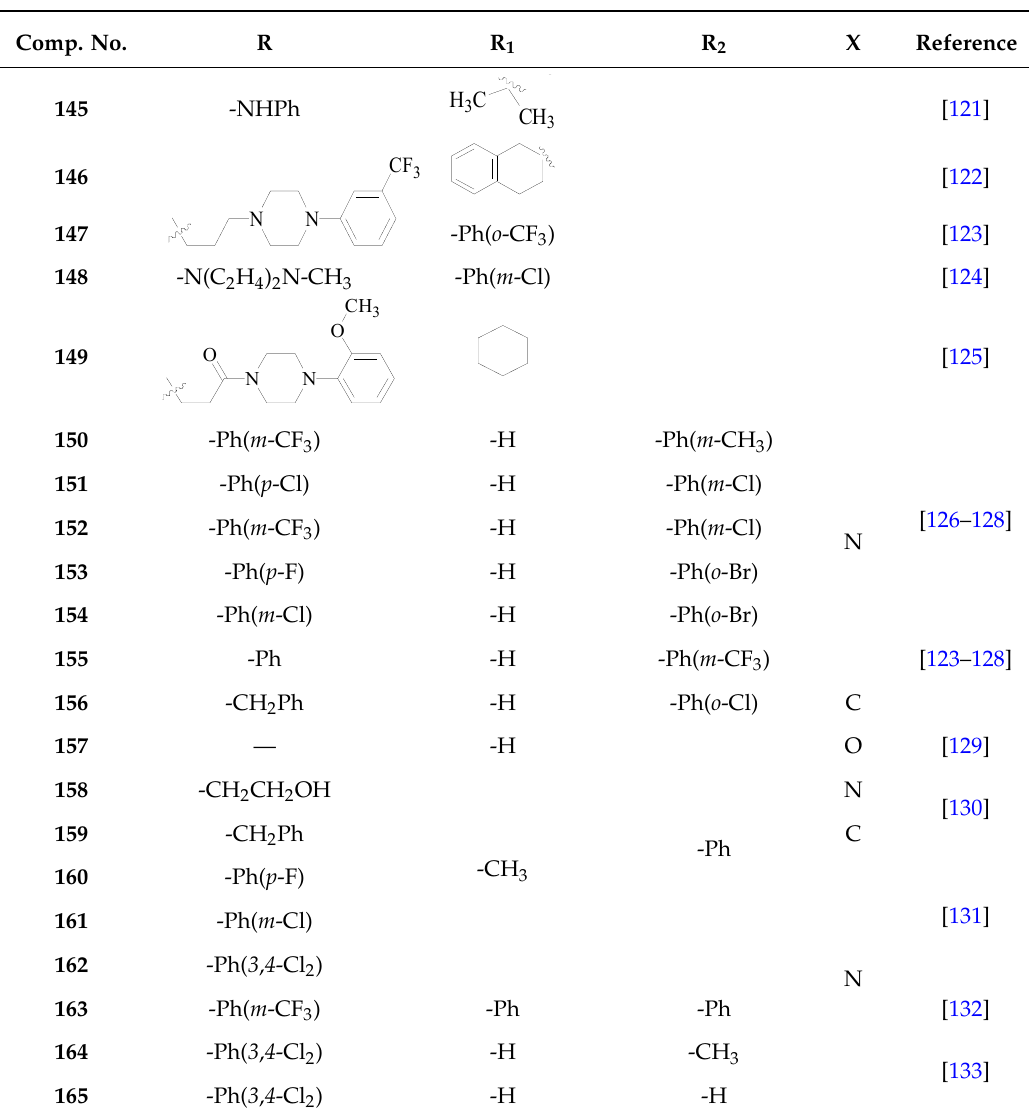
Table 7. Structures of compounds 132 – 165